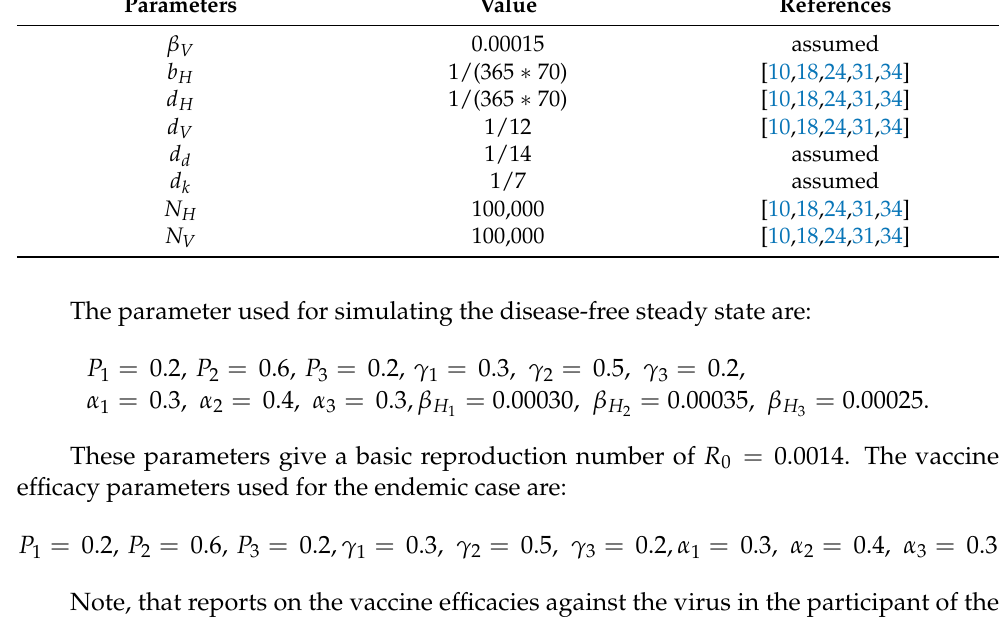
Figure 9. The trajectory of vector population I V toward the endemic steady state for R 0 > 1. Table 2. Sensitivity indices.